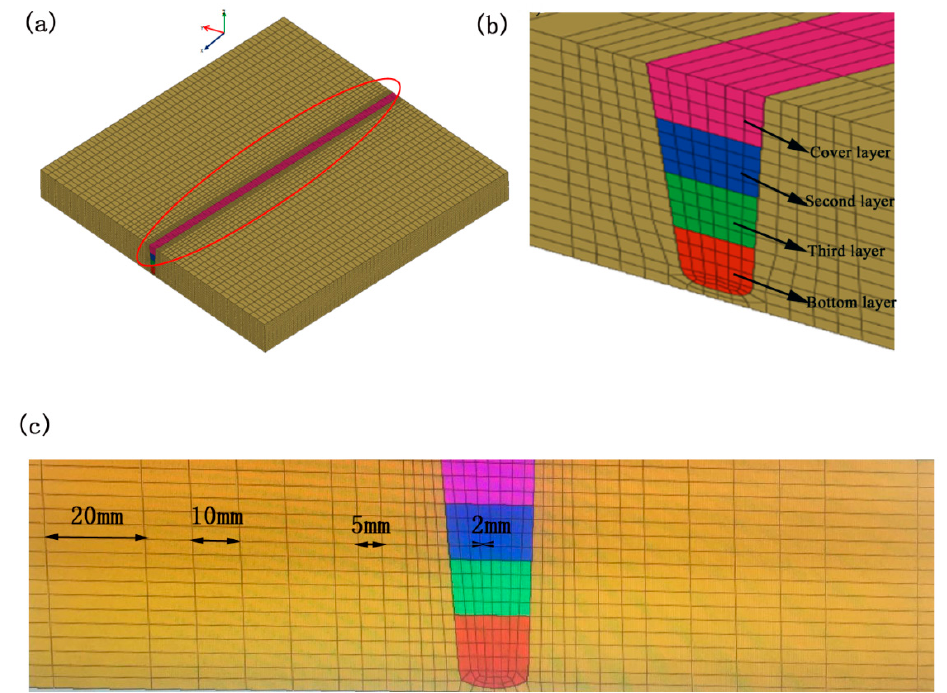
Figure 8. ( a ) Mesh refinement for the weld region of the coupon (the red circle); ( b ) four weld layers of the welding joint represented by four colors; ( c ) the mesh sizes used in the finite element model.